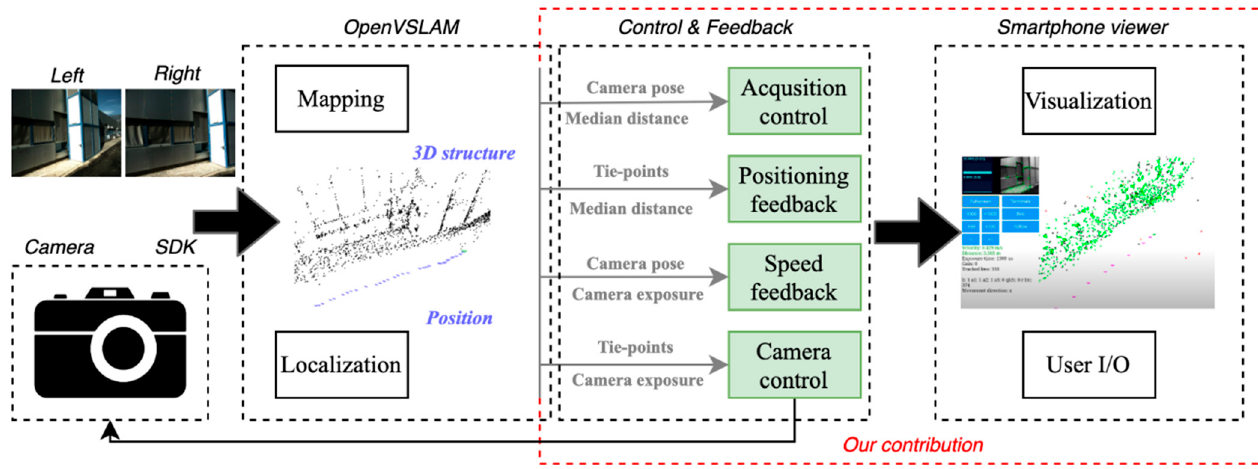
Figure 3. High level overview of the proposed system, highlighting our contribution. The images acquired by the synchronized stereo cameras are used by the V-SLAM algorithm to estimate in real-time the local position of the device and a sparse 3D structure of the surveyed scene. Camera positions and 3D structure are used in real-time to optimize and guide the acquisition.